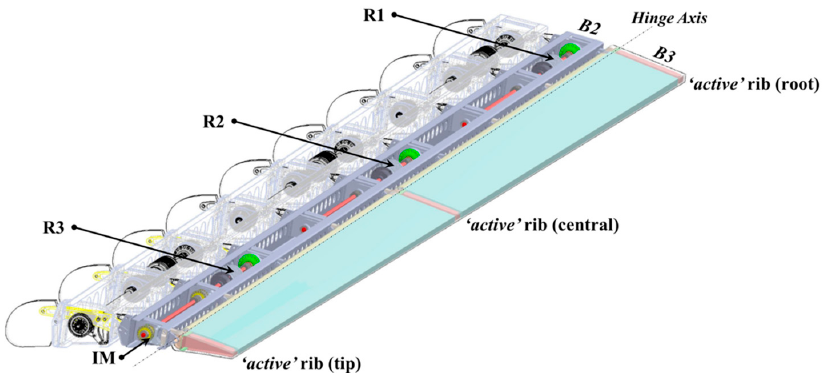
Figure 4. Multifunctional Twistable Wing Trailing-edge mounted on the tip of a Fowler flap: 3D-CAD.